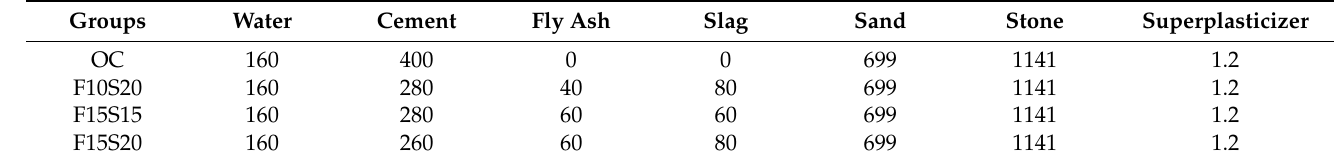
Table 2. Concrete mix proportions (kg/m 3 ).